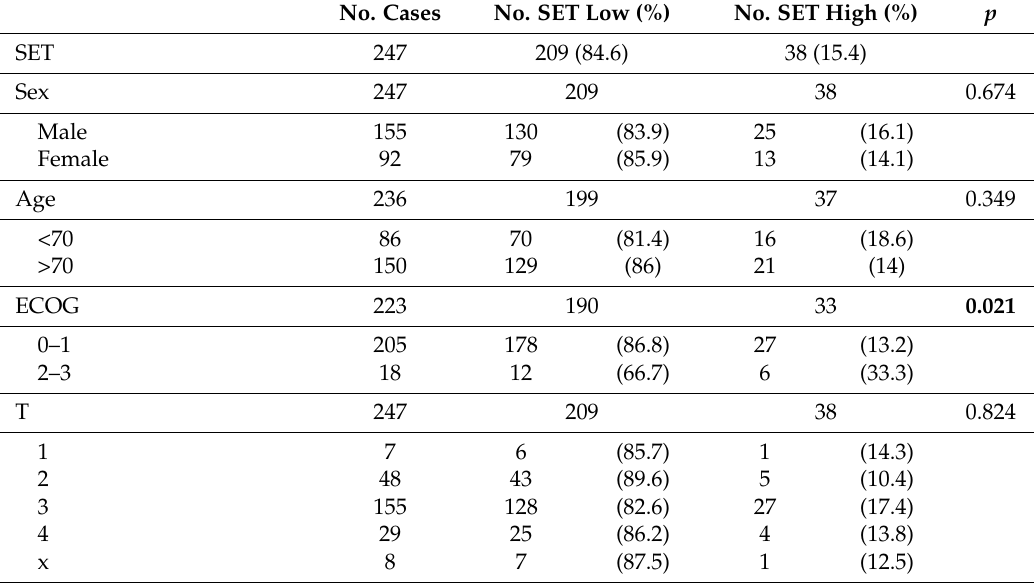
Table 1. Association between SET and clinical and molecular parameters in 247 CRC patients without metastatic disease at